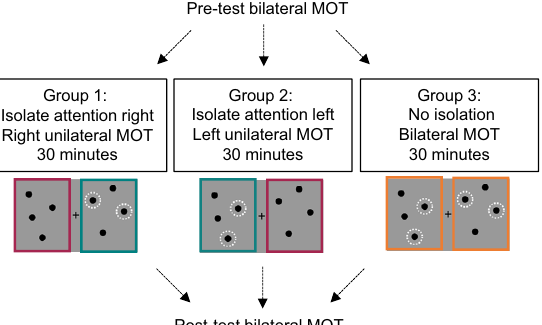
attention increase during the manipulation period, when the task was focused within one visual field for 30 min. Furthermore, we split the during-manipulation data into 10-min time-bins to examine how isolation impacted behavior across the 30-min period. We found no main effect of group ( χ 2 (1) = 2.8603, p = 0.09, glmer ), nor time- bin ( χ 2 (2) = 2.5785, p = 0.2748, glmer ) but we did find an interaction between group and time-bin ( χ 2 (2) =